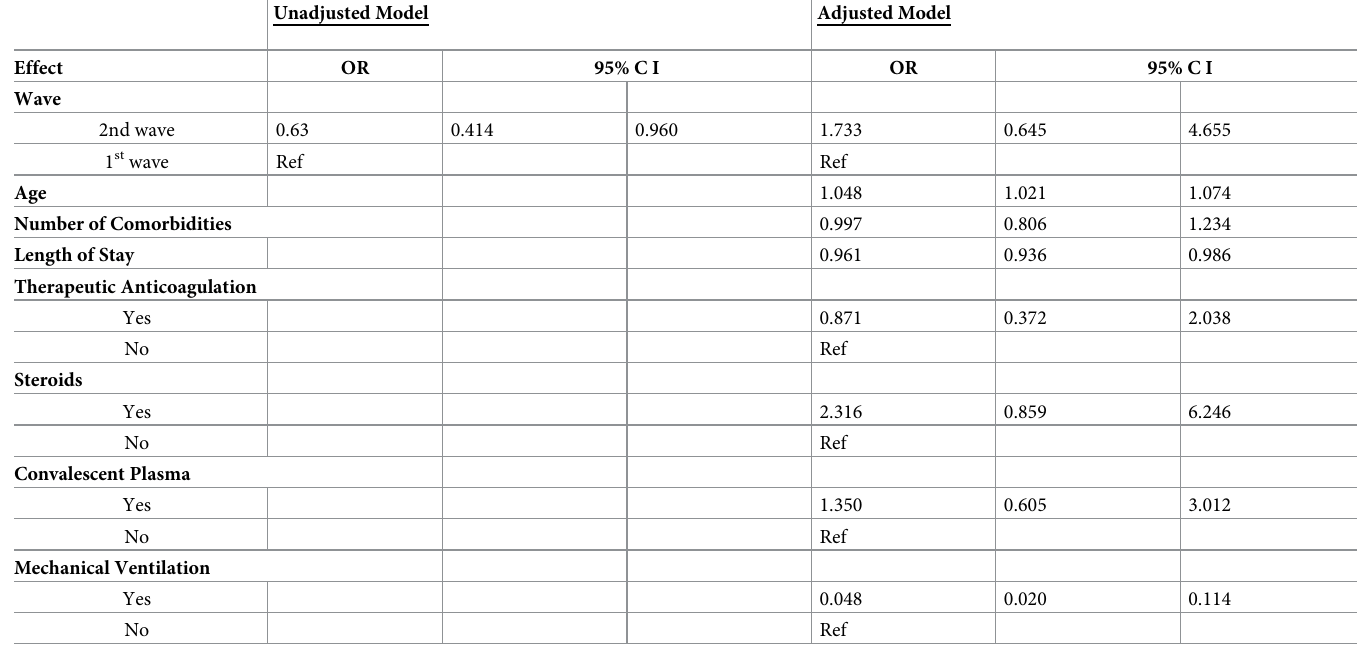
Table 3. Logistic regression model comparing mortality between the first and second wave and other